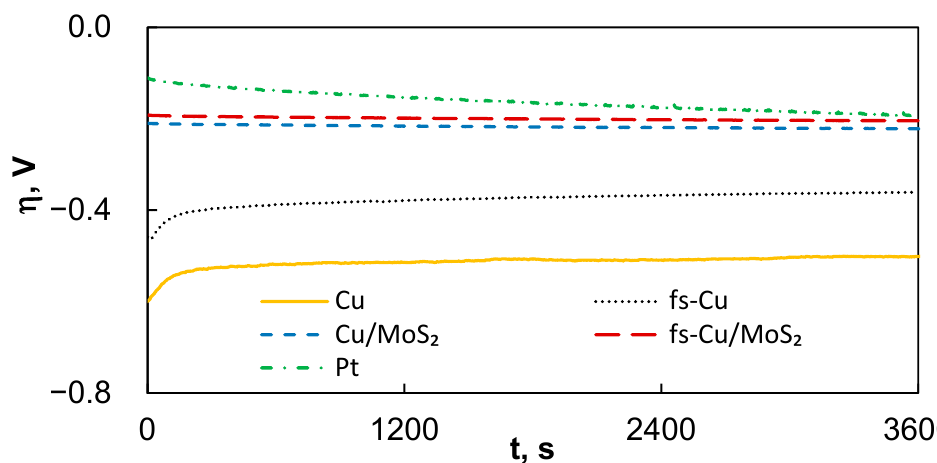
Figure 5. The overpotential-time curves that represent the electrochemical steady-state activity of the electrodes under 10 mA cm − 2 of applied current density.